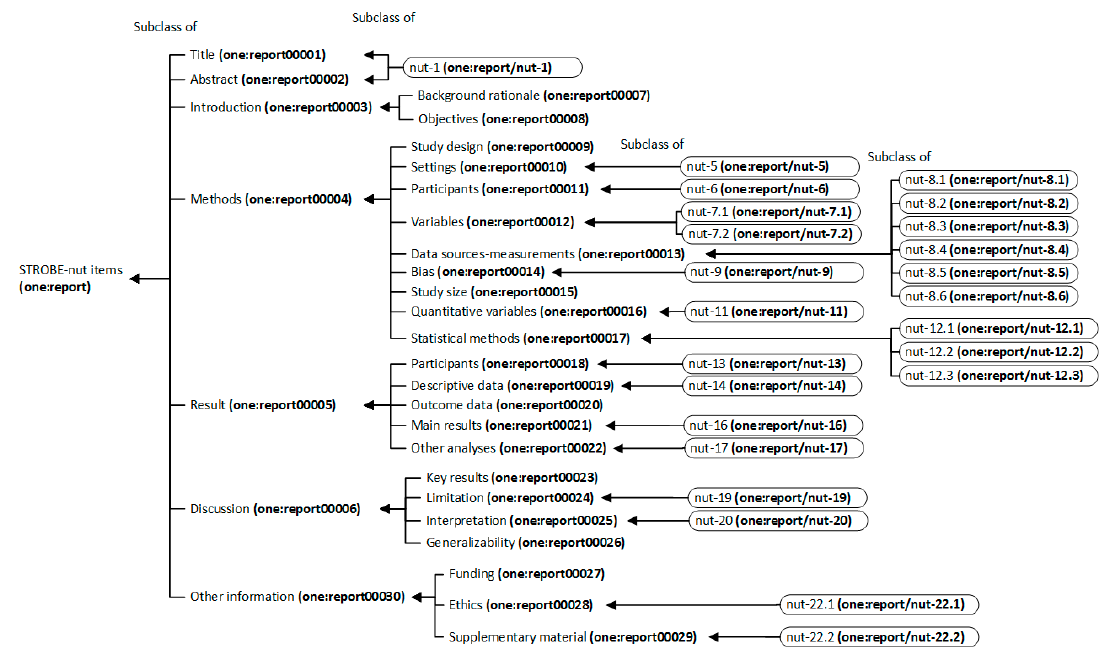
Figure 5. The ontology taxonomy of strengthening the reporting of observational studies in epidemiology (STROBE)-nut (nutritional epidemiology) items.